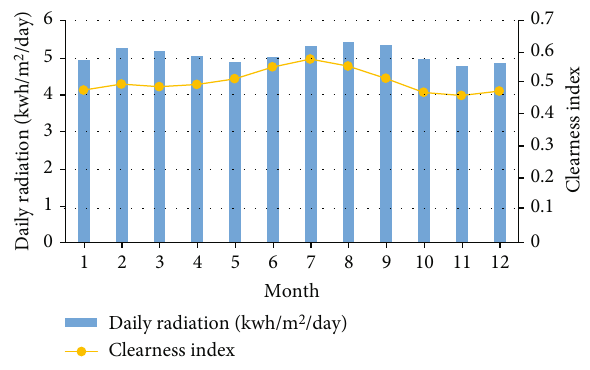
Figure 4: Solar energy pro fi le at the preferred